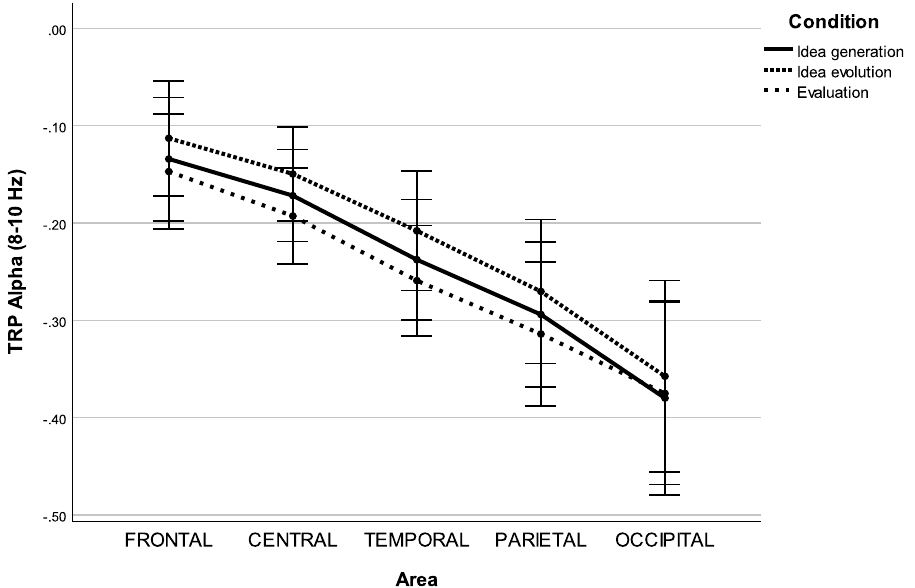
Figure 1. Task-related power in the lower alpha band during idea generation, idea evolution, and